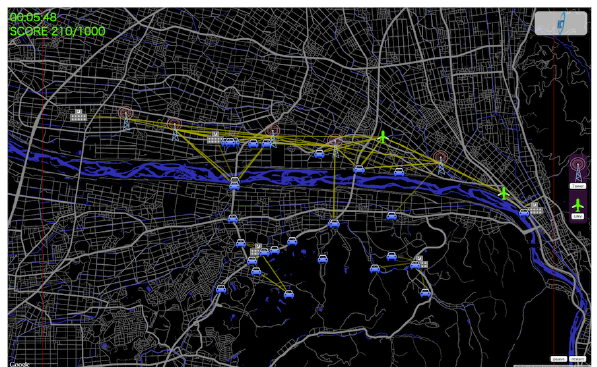
Figure 2: The 2D visualizer and user